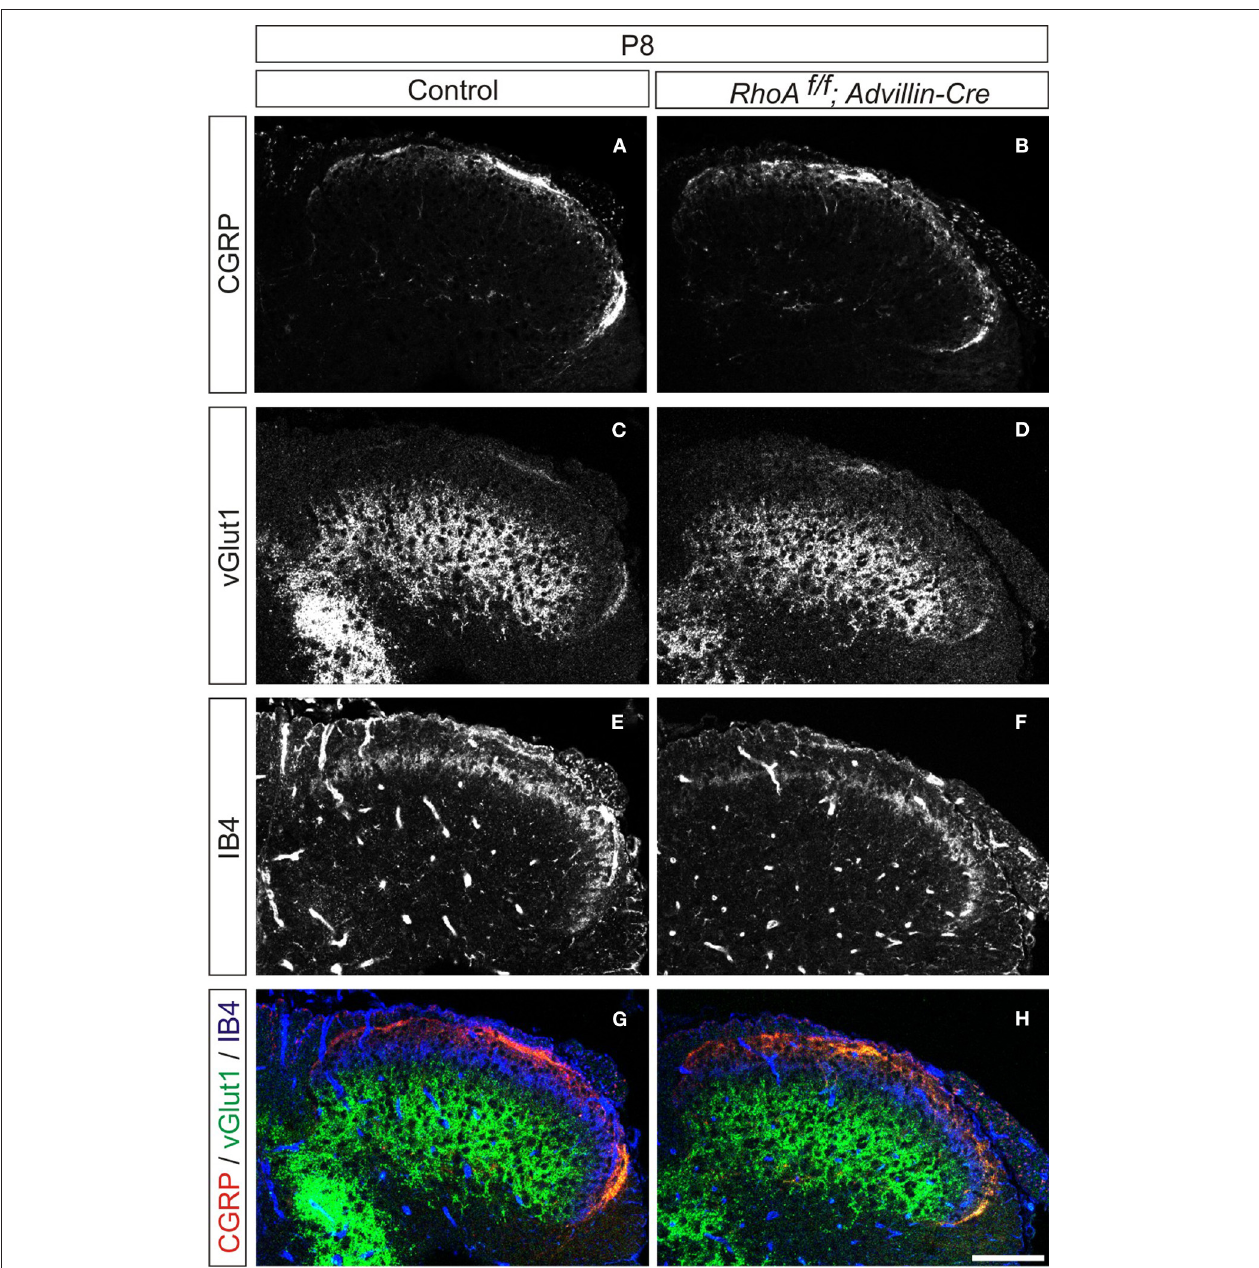
FIGURE 6 | Organization of cutaneous afferent projections in RhoA f / f ; Advillin-Cre mice. (A,B) CGRP expression, (C,D) vGlut1 expression, (E,F) IB4-binding, and (G,H) merged views of CGRP (red), vGlut1 (green), and IB4-binding (blue) in P8 control and RhoA ; Advillin-Cre f / f mice. Scale bar, 100 µ